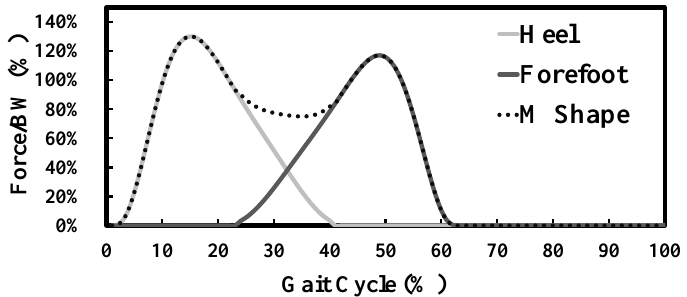
Figure 19. M-shaped force: the qualitative behavior of the heel and the forefoot forces are based on ISO 10328 dynamic test, while the maximum values (130% of the body weight for the heel force and 108% for the forefoot force) are from literature—see the Biomechanical Requirements in Section 2.4. In the present work, a 60 kg body weight was used; therefore the peaks were 764 N and 635 N. The forces were imposed as shown in Figure